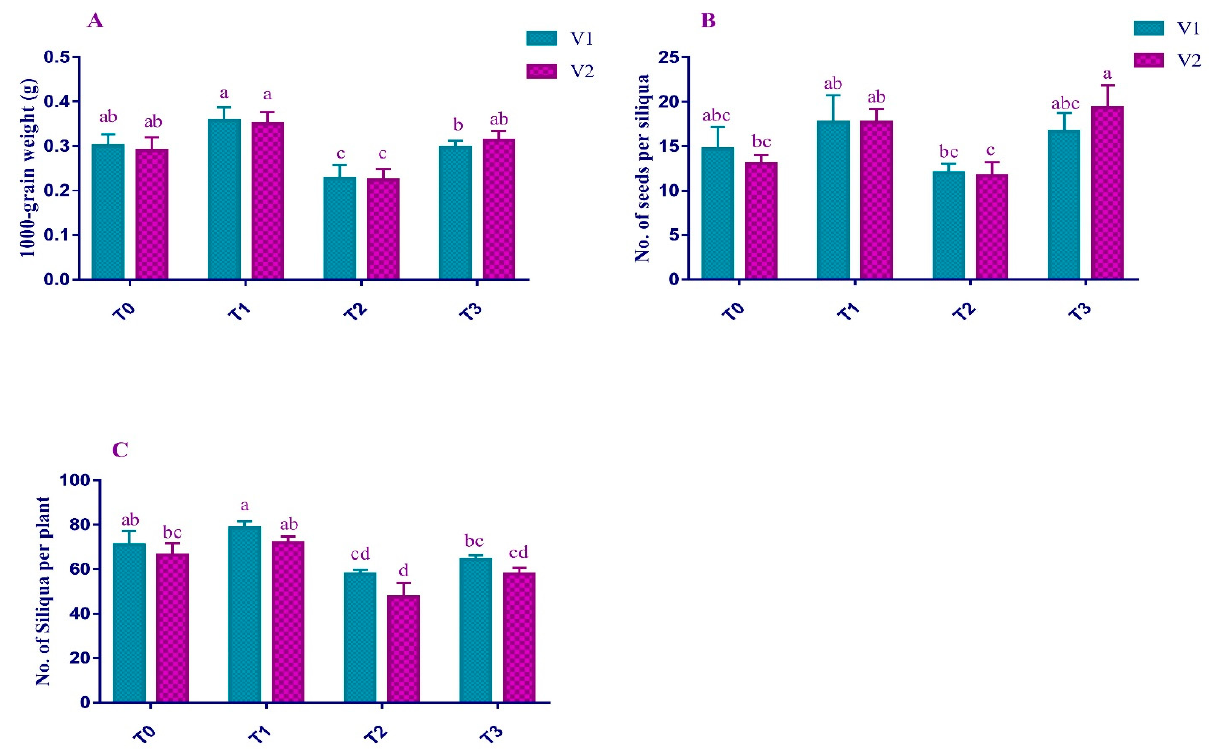
Figure 6. Effect of Pb and EDTA on ( A ) 1000 seed weight (g), ( B ) number of seeds per siliqua and ( C ) number of siliqua per plant, and of brown mustard. Error bars above means indicate the ± SE of three replicates. Means sharing a letter for a parameter do not differ significantly at p ≤ 0.05. V1 = Faisal cultivar; V2 = Rohi cultivar; T 0 = 0 mM EDTA + 0 mM Lead acetate; T 1 = 2.5 mM EDTA + 0 mM Lead acetate; T 2 = 0 mM EDTA + 0.5 mM Lead acetate; T 3 = 2.5 mM EDTA + 0.5 mM Lead acetate.